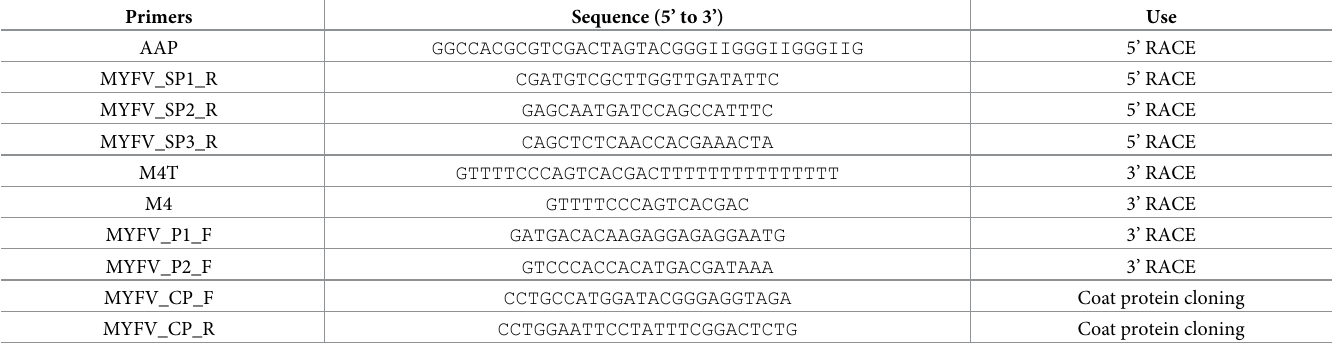
Table 1. Primer sequences used for 5’ and 3’ Rapid Amplification of cDNA Ends (RACE) and coat protein cloning.